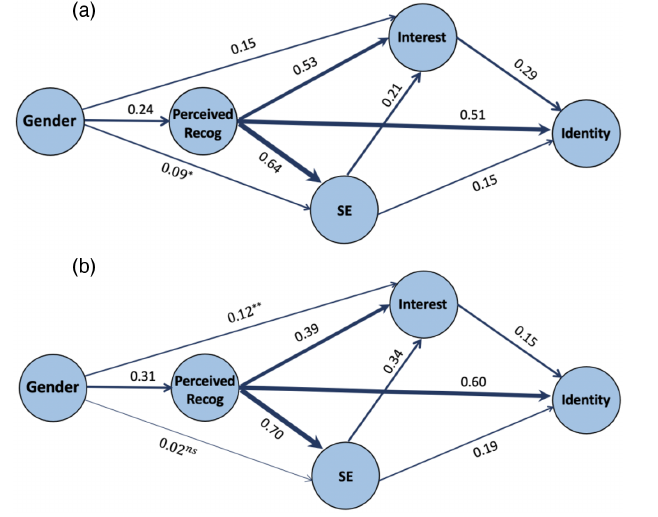
FIG. 3. Results of the path analysis part of SEM model 2, in which perceived recognition (Recog) predicts self-efficacy (SE) and interest, and self-efficacy predicts interest. (a) Shows the results of using physics 1 data, and (b) shows the results for physics 2 data. The solid lines represent regression paths, and the numbers on the lines are standardized regression coefficients ( β values), which represent the strength of the regression relations. Each regression line thickness qualitatively corresponds to the magnitude of the β with 0 . 001 ≤ p < 0 . 01 indicated by **, 0 . 01 ≤ p < 0 . 05 indicated by *, and p ≥ 0 . 05 indicated by ns (not significant). All the other regression lines show relations with p < 0 . 001 .